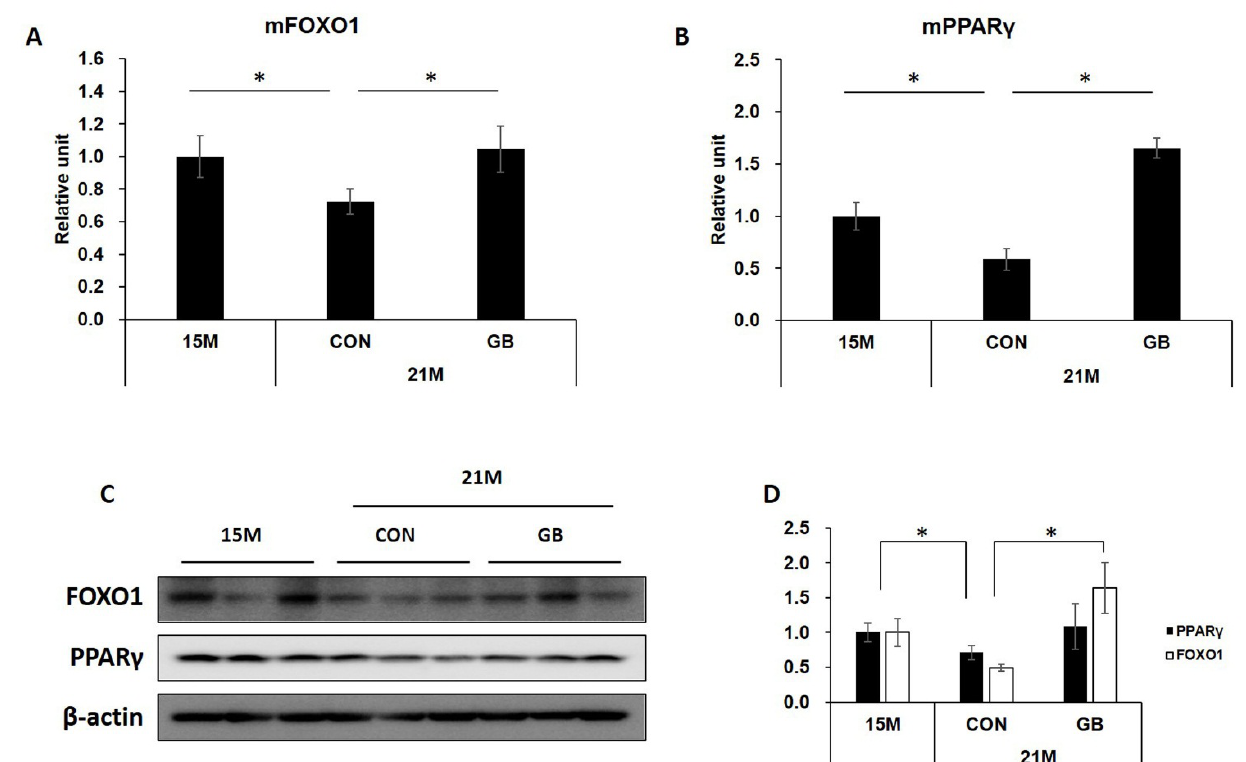
Figure 6. Ginseng berry (GB) extract supplementation increases the expression of forkhead box protein O1 (FOXO1) and peroxisome proliferator activated receptor gamma (PPARγ) in skeletal muscle of aged mice. Fifteen-month-old mice were fed a regular diet (CON) or regular diet supplemented with 0.05% ginseng berry extract (GBD) for 6 months ( n = 8 in each group). Skeletal muscle tissues were collected 7 min after insulin injection (2 U kg −1 , i.p.). ( A ) FOXO1 and ( B ) PPARγ mRNA levels were measured by qRT-PCR. Relative units were determined as a ratio of mRNA levels of 15-month-old mice; ( C ) Protein expression of FOXO1 and PPARγ was determined by western blot; ( D ) The images derived from ( C ) were analyzed through ImageJ software for Windows. Values are means ± SE. * p <